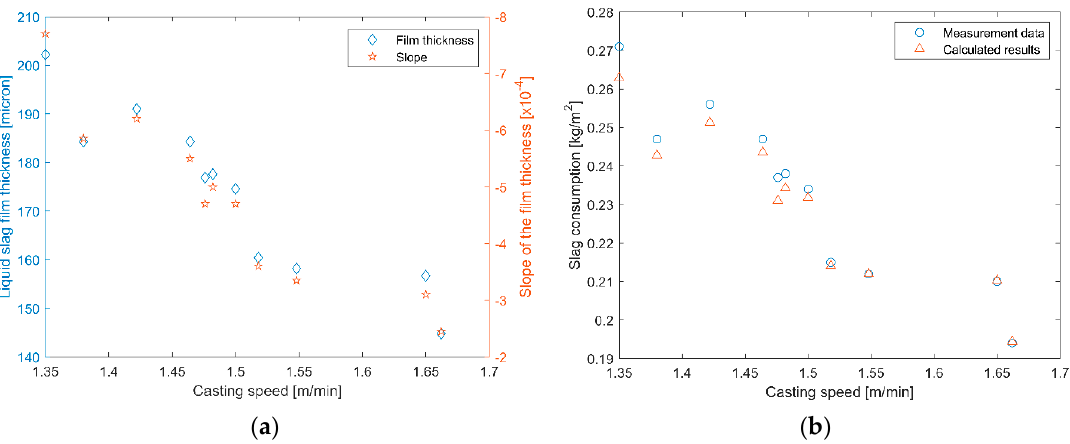
Figure 12. ( a ) Liquid film thickness, slope of the film, and ( b ) slag consumption with different casting speed (Case